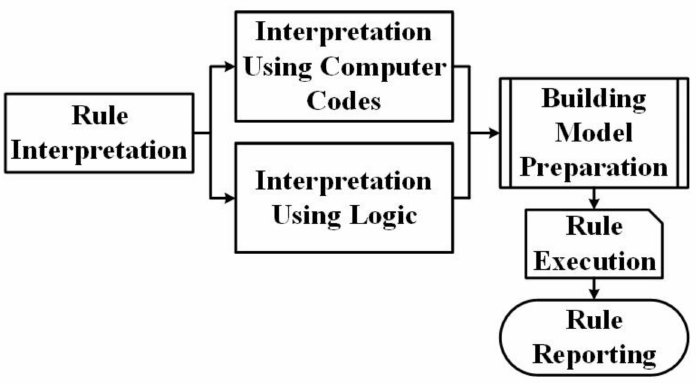
Figure 5. General structure of the rule-checking